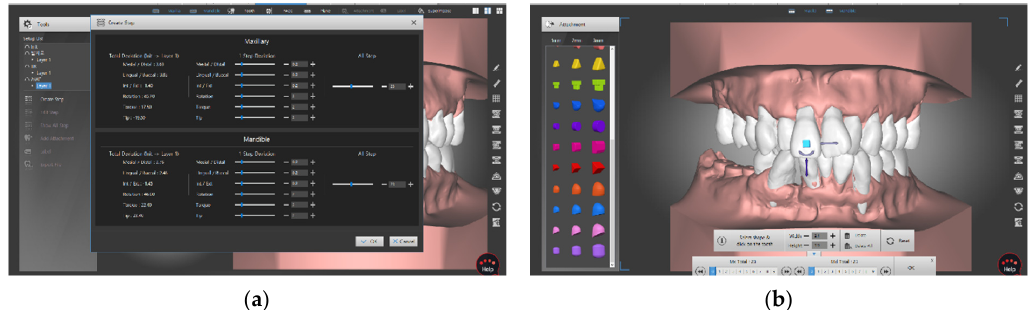
Figure 9. ( a ) A screen with a rotation of 2 degrees within one step, a movement distance of 0.2 mm, and tooth movement planned in 23 steps. ( b ) If necessary, an attachment can be added to the tooth.